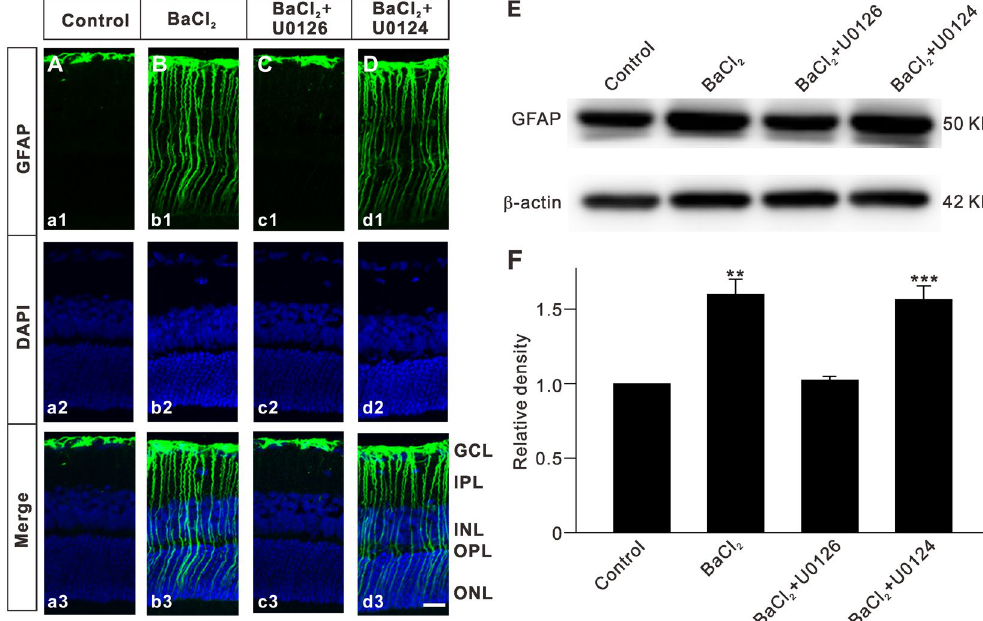
Figure 1. Inhibition of Kir channels induces an elevation of GFAP expression in Müller cells by activating MAPKs. Vehicle (0.9% saline), BaCl 2 , BaCl 2 + U0126 or BaCl 2 + U0124 was injected into the vitreous space in a volume of 2 μ L, respectively. ( A – D ) Immunofluorescence labeling showing the changes in GFAP protein expression in rat retinal vertical slices taken from vehicle (Control) (Aa1), BaCl 2 (Bb1), BaCl 2 + U0126 (Cc1) or BaCl 2 + U0124 (Dd1) injected retinas, respectively. a2–d2 are corresponding DAPI images and a3–d3 show the merged images. Scale bar, (for all the images) 20 µ m. GCL, ganglion cell layer; IPL, Inner plexiform layer; INL, inner nuclear layer; OPL, outer plexiform layer; ONL, outer nuclear layer. ( E ) Representative immunoblots showing the changes in GFAP protein levels under different conditions as shown in ( A–D ). ( F ) Bar charts summarizing the average densitometric quantification of immunoreactive bands of GFAP protein expression under different conditions. All data are normalized to control. n = 6 for each group. ** P < 0.01 and *** P < 0.001 vs .